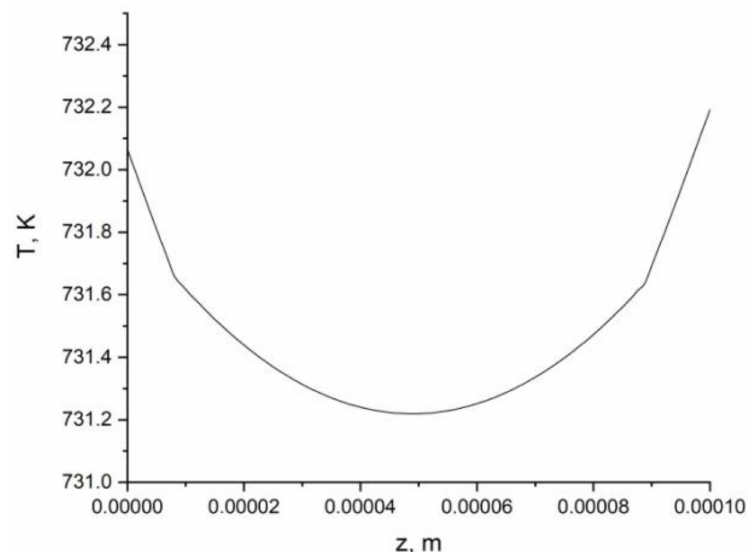
Figure 3. Temperature distribution over the thickness of a birch leaf under the influence of a low- intensity surface forest fire at time t = 2 s (summer, July, +20 ◦ C, ϕ 30 = 0.4).